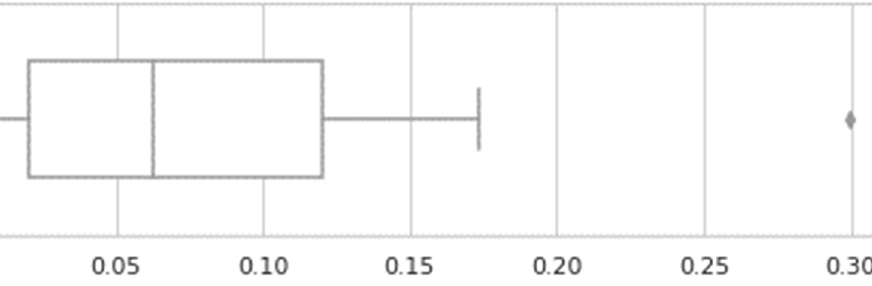
Table 6. Prediction results using the BIM setups for 10 datasets.